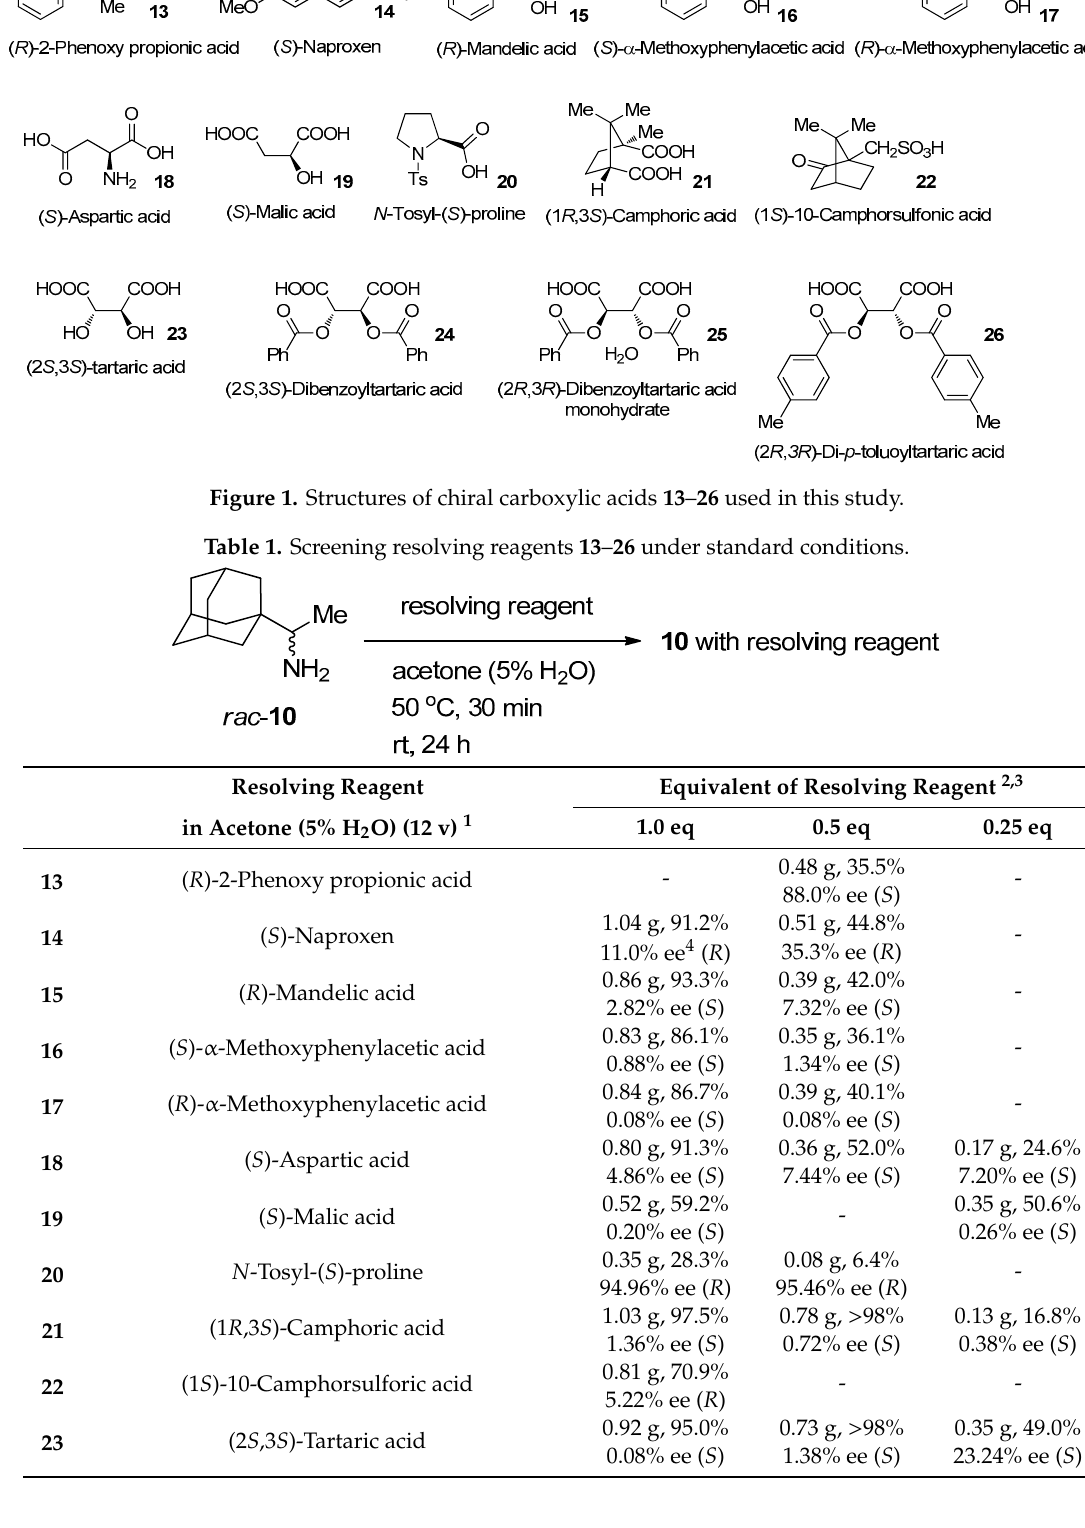
Figure 1. Structures of chiral carboxylic acids 13 – 26 used in this study.